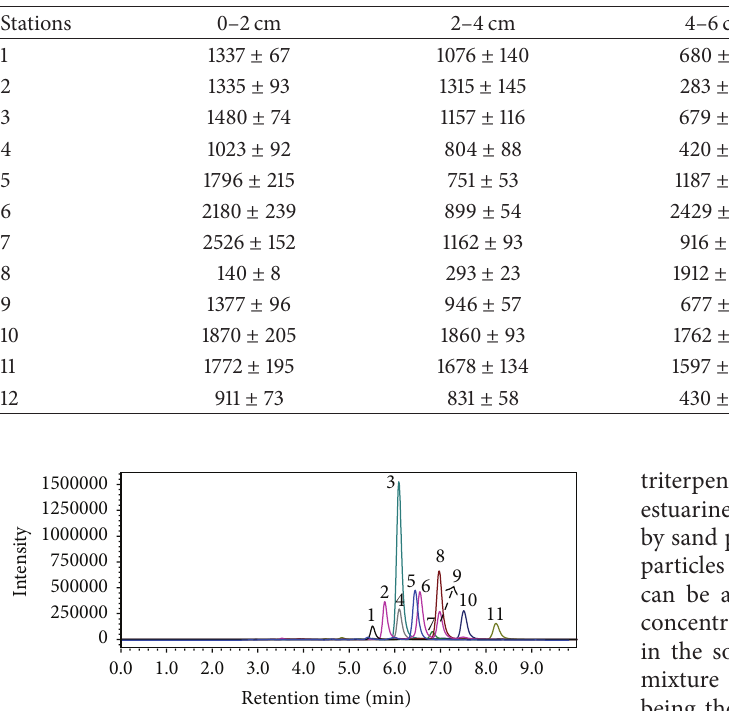
Table 2: Total concentrations of sterols and triterpenols (ng/g of dry weight) in sedimentary core samples from the Canan´eia-Iguape estuarine-lagoonal system ( 𝑛 = 3 ).